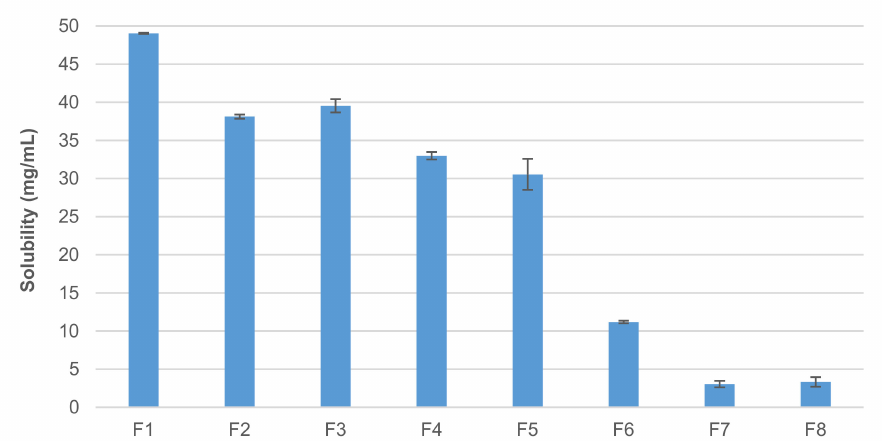
Figure 1. Flecainide acetate solubility in different aqueous vehicles (25 ± 1 ◦ C). Mean ± SD ( n =